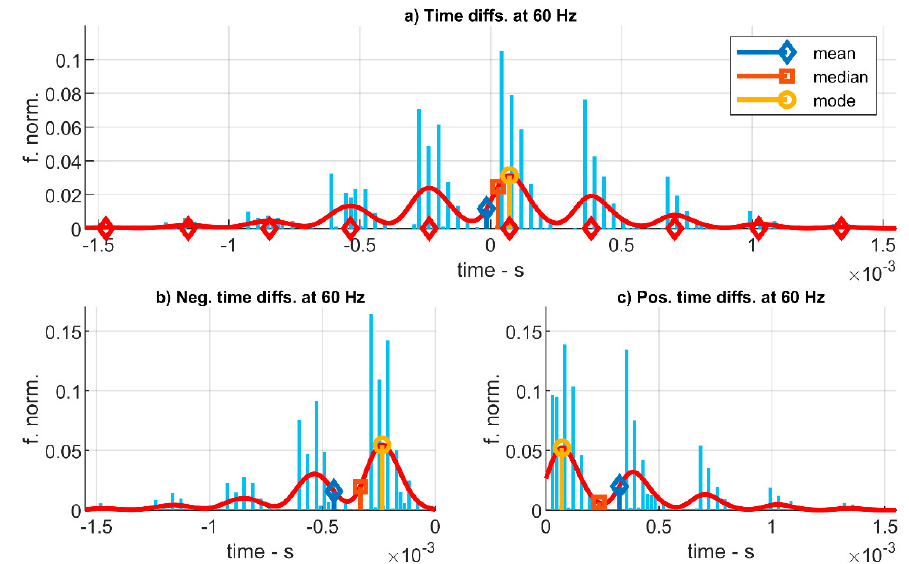
Figure 13. High-resolution histogram of the time errors registered for each sound wave’s period at a frequency of 60 Hz. ( a ): Errors are fitted to a kernel distribution. ( b , c ): Positive and negative errors are separately fitted to kernel distributions.